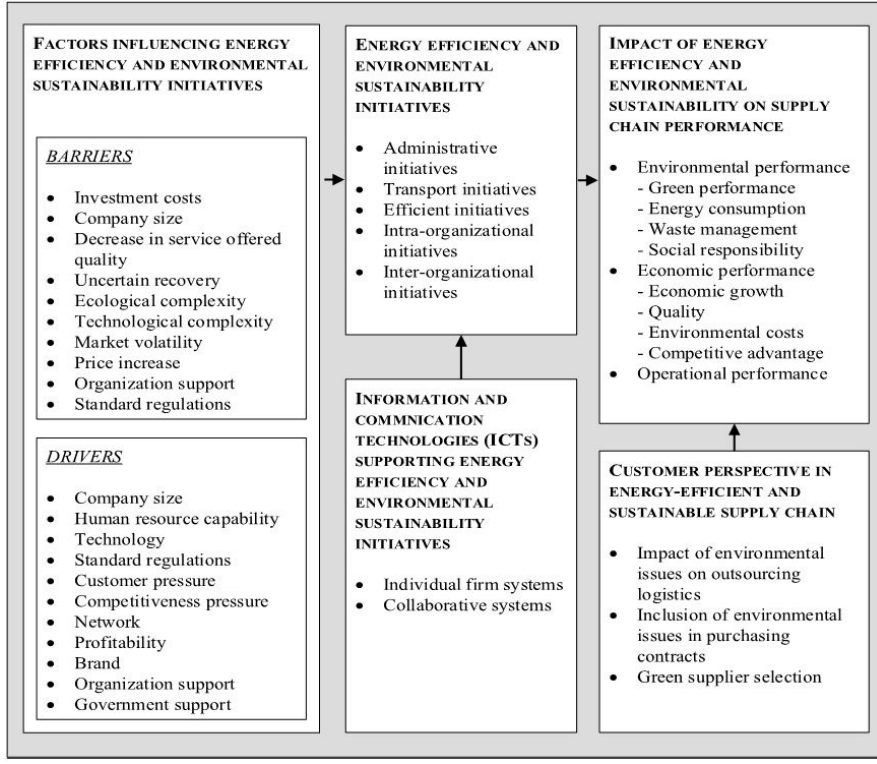
Figure 2. Literature map of environmental sustainability and energy-efficient supply chain